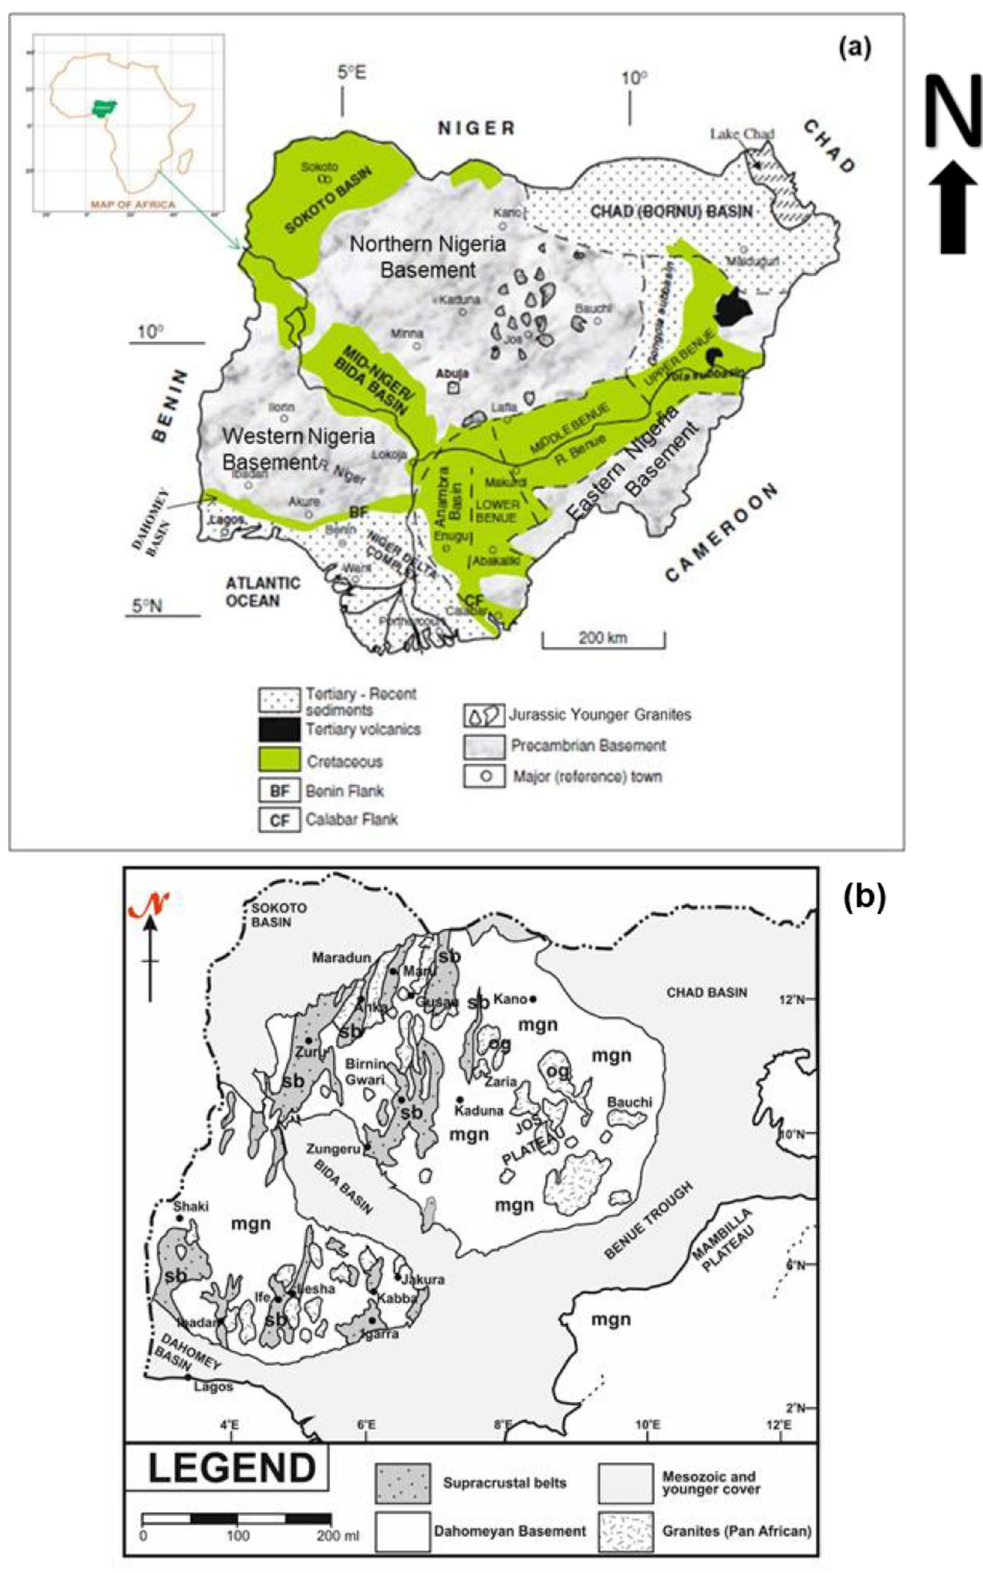
Figure 1. ( a ) Geologic Map of Nigeria showing the Basement complex and the sedimentary basins (Modified after 13 ) and ( b ) Basement Geology of Nigeria: The migmatite-gneiss complex (mgn), the schist belts (sb) and the older granites (og) (Modified from 15